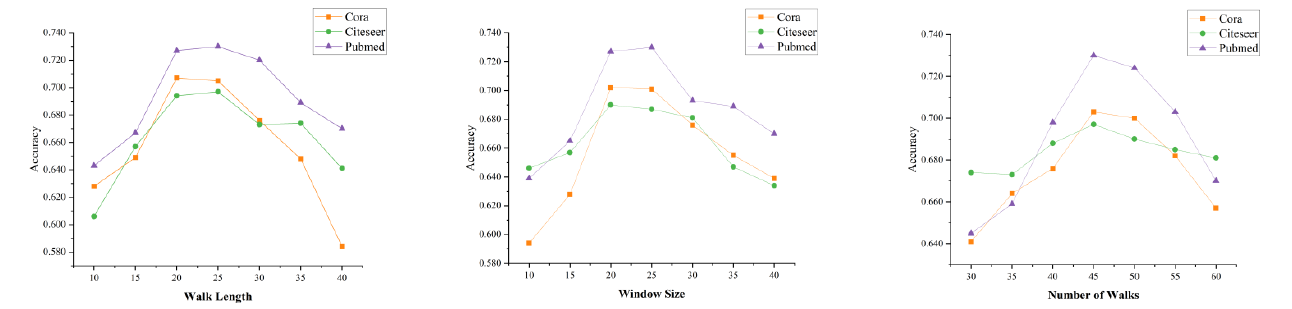
Figure 3. Analysis for walk length, window size, and number of walks. Table 6. Differences in the accuracy of node clustering with different neighbor orders.